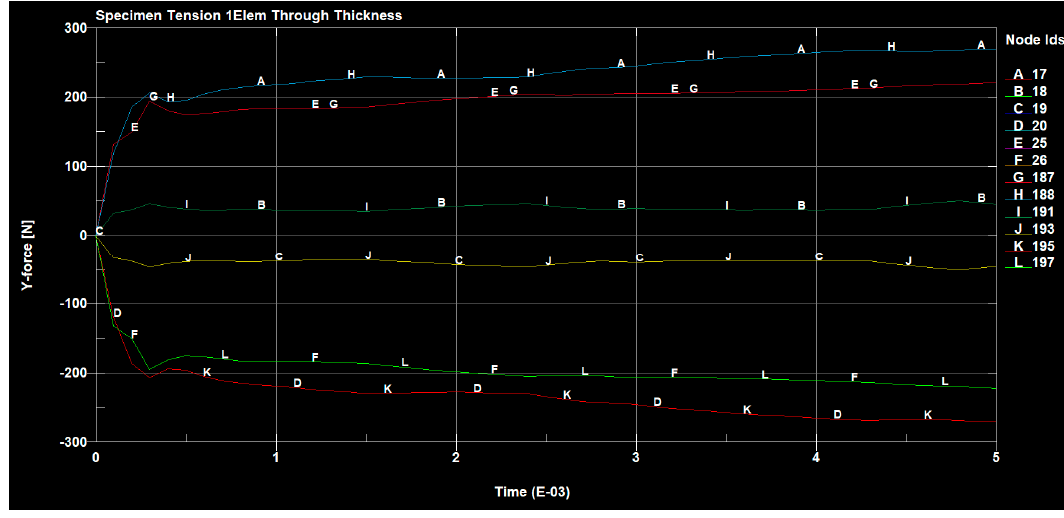
Figure 31. Tensile forces occurring on the sample in the 𝑦 direction.